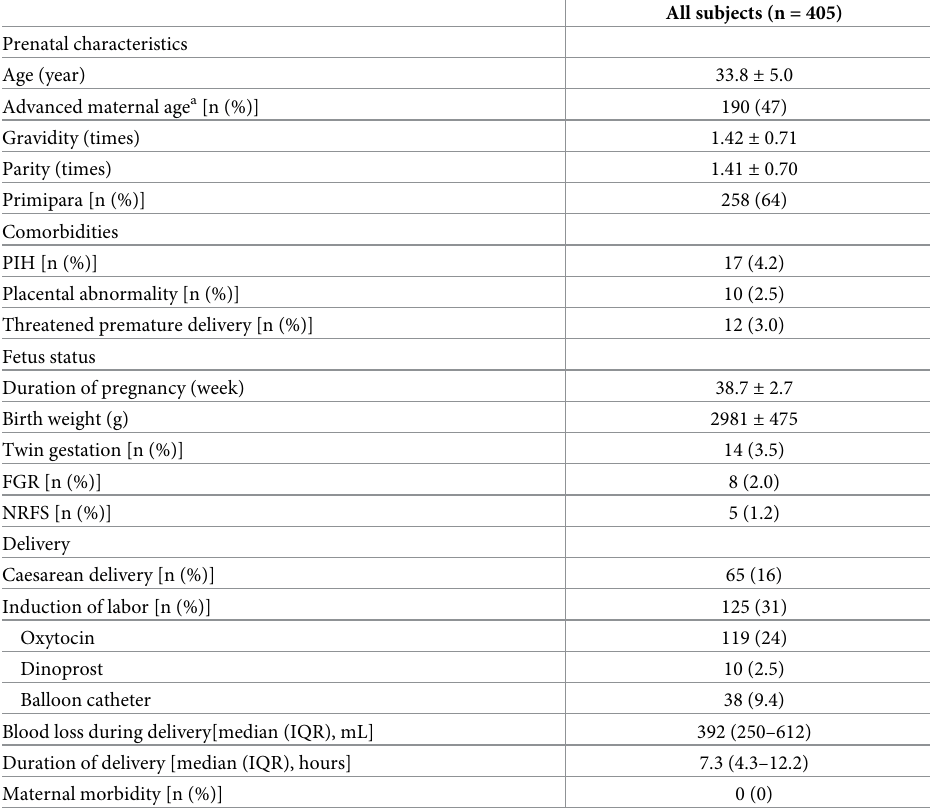
Table 1. Prenatal and peripartum